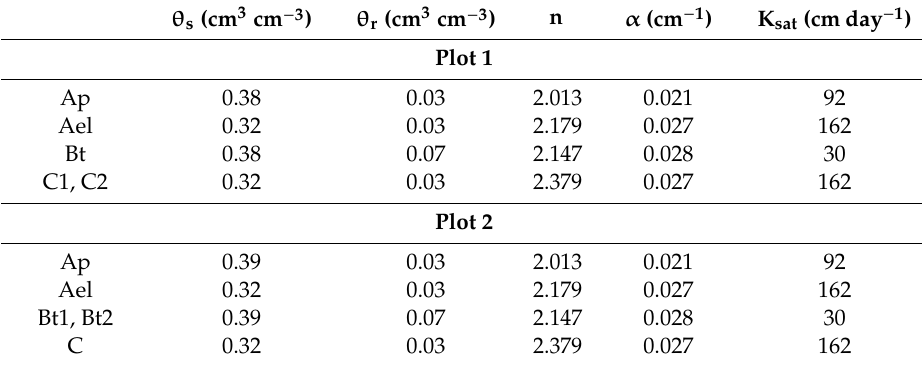
Table 2. Parameters θ s , θ r , n and α for θ (h)-and K(h)-functions and saturated hydraulic conductivities K sat , data from [35]